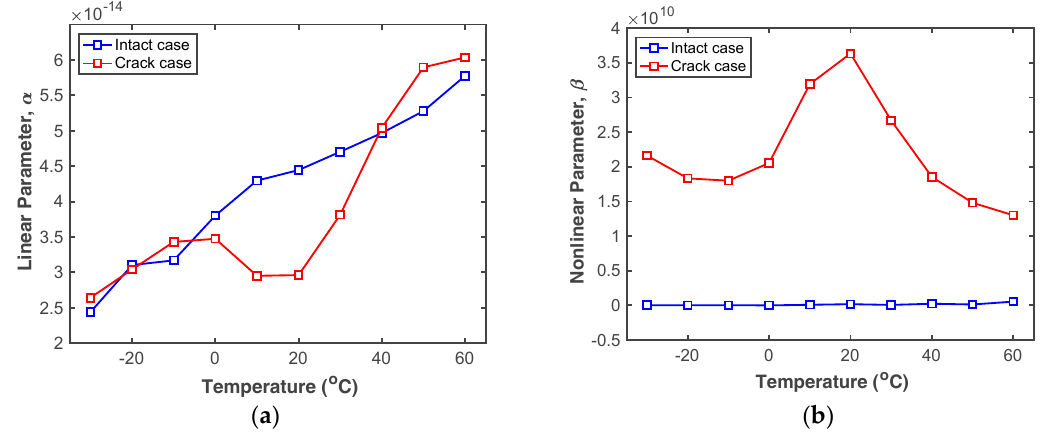
Figure 4. Comparison of ( a ) α and ( b ) β obtained from the intact and cracked FE models at different temperatures.